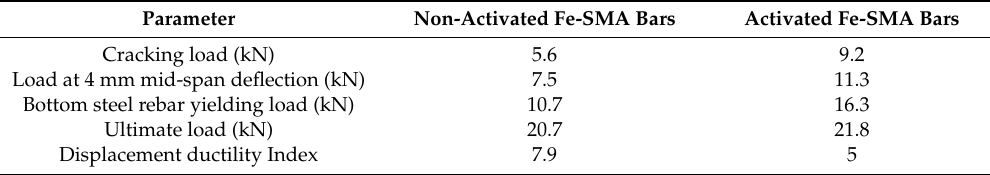
Table 2. Comparison of beams strengthened with activated and non-activated Fe-SMA bars.